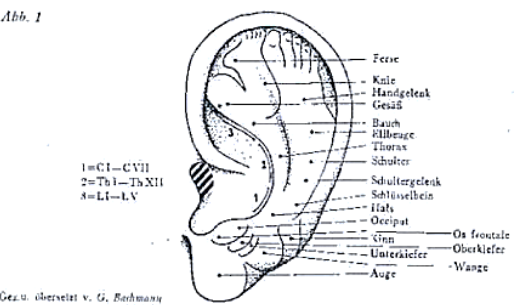
Figure 3. The first Auricular map published by Paul Nogier in 1957. The head is represented towards the lower lobule, the hands and feet are represented at the uppermost portion of the auricle and the body in between. Copyright Raphael Nogier. Published with his authorization.